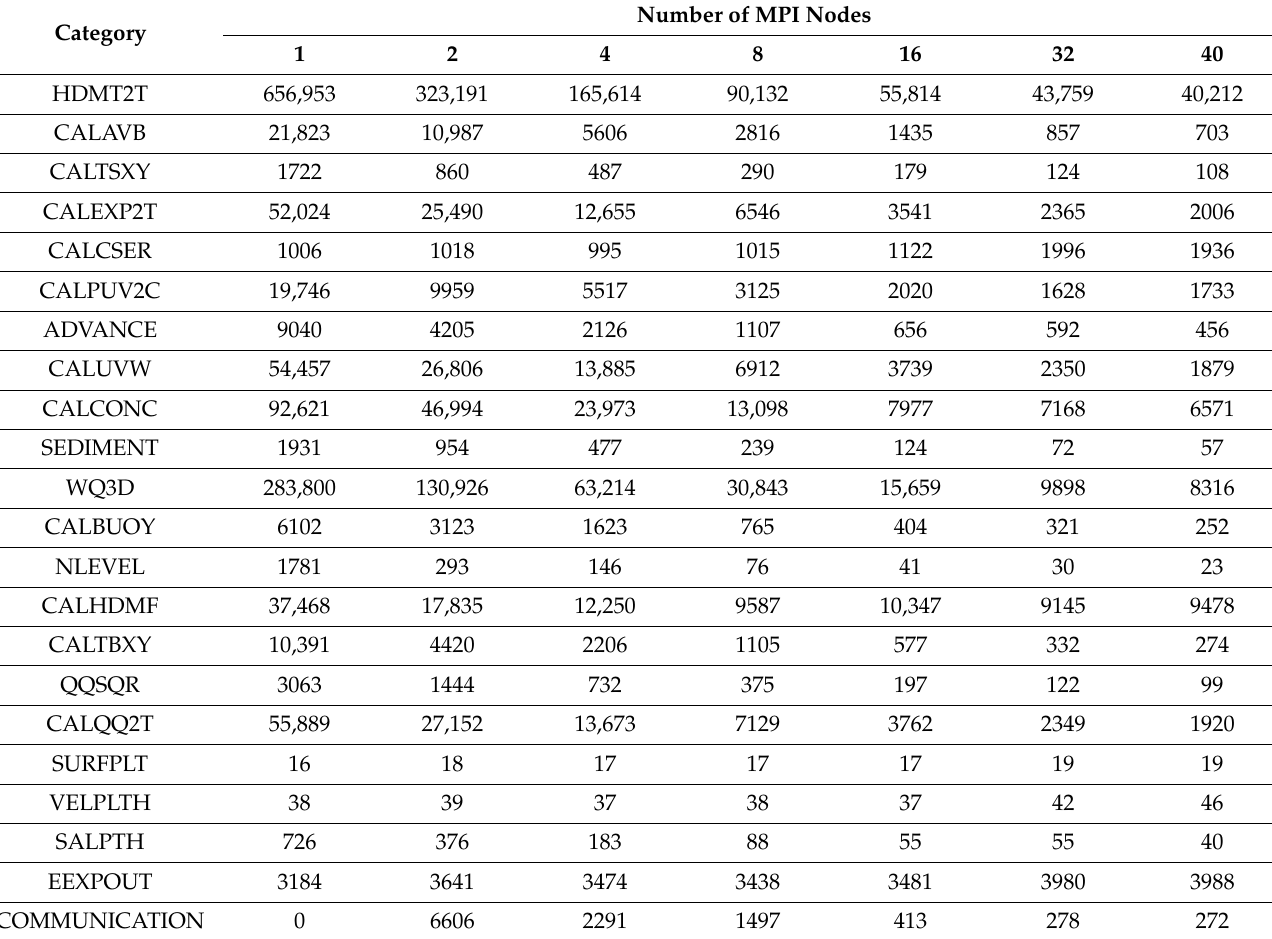
Table A7. Execution time for each function based on the number of MPI nodes (detailed grid #2 of Nakdong River).